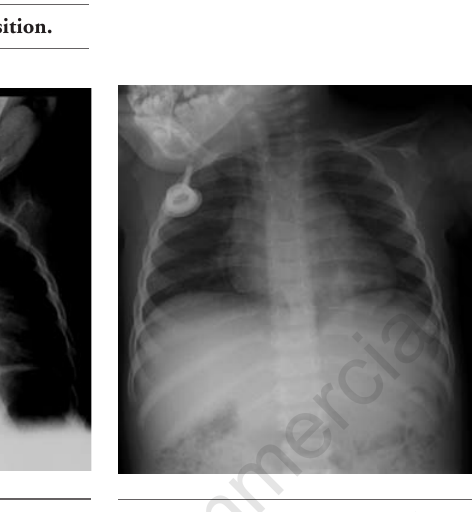
Figure 7. Case #4. Initial tip position. Figure 8. Case #3. Tip position after 2